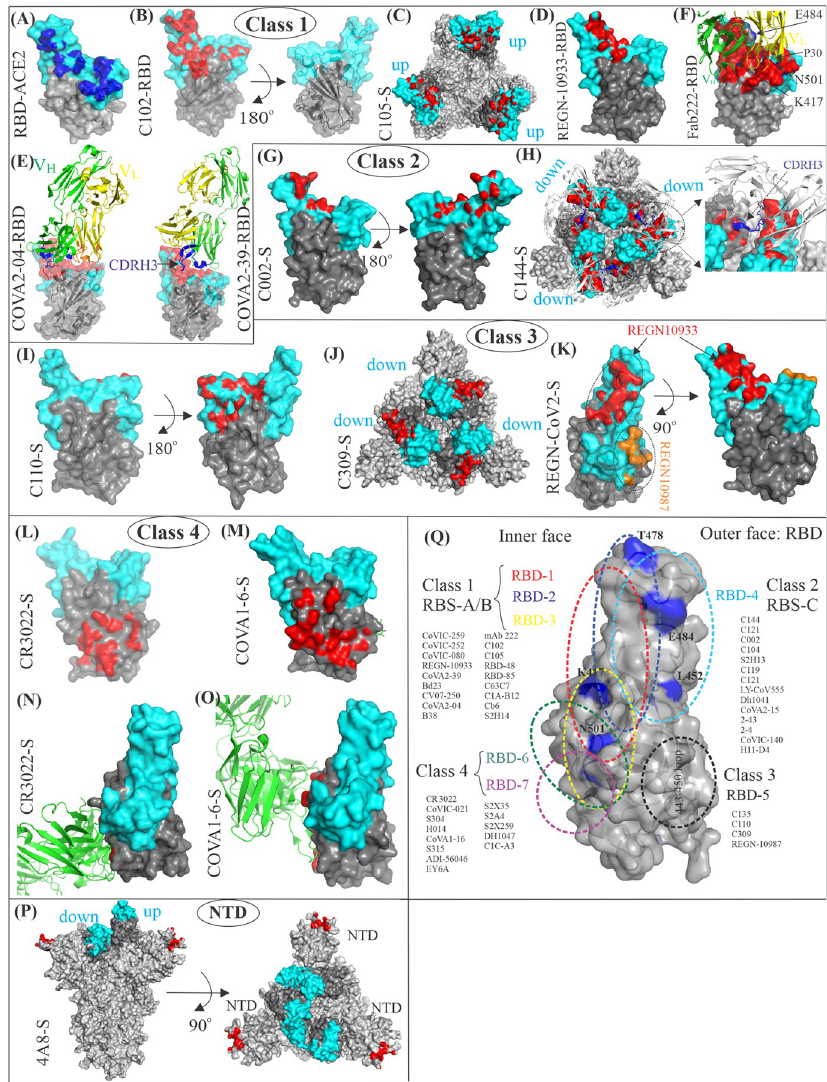
Fig 4. Structural analysis and classification of nAbs of the SARS-CoV-2 spike protein. (A) Structural footprints of ACE2 in blue on the RBM (cyan) (PDB: 6M0J). (B, C, D) The C102, C105, and REGN-10933 antibodies in complex with either isolated RBD or the spike trimer illustrate a conserved mode of binding to RBD in the up-conformation. Binding of C102 to the RBM on the RBD in red overlaps with the ACE2-binding site (PDB: 7K8M). (E) COVA2-39 (PDB: (7JMP) with a relatively longer CDRH3 loop binds the RBD in an alternative binding mode, as compared to the antibodies with a shorter CDRH3 loop, such as COVA2-04. (F) Fab222 binds RBD (PDB: 7NX6) with a relatively shorter CDRH3 loop. Residues K417, E484, and N501 are mutated in Alpha, Beta, and Gamma variants and are highlighted in red on the cyan ACE2-binding interface. (G) Structural footprints of a Class 2 antibody C002 on the RBD in red illustrates that the binding occurs toward the outer edge of the RBM (PDB: 7K8S). (H) The C144-spike protein complex structure revealed 3 C144 binding to a closed spike with all down-conformation RBDs (PDB: 7K90). The C144 epitope (red) spans between 2 adjacent RBDs on the surface of the trimeric spike. Close-up view of a quaternary epitope of C144 (red) bridging 2 adjacent monomers by the CDRH3 loop (blue). Class 1 and class 2 antibodies have significant overlap, but class 2 antibodies have fewer structural footprints on the ACE2-binding site at the RBM than class 1 antibodies (see B and G) (I) Structural footprints of a Class 3 antibody C110 on the RBD in red illustrates that C110 recognize a conserved epitope away from the receptor binding site and toward the outer face of the RBD. (J) The C309-spike protein structure illustrates that they bind outside of the ACE2-binding site. (PDB: 6WPS). (K) REGN-CoV2 is an antibody cocktail comprised of REGN10933 and REGN10987. REGN10933 blocks the ACE2-binding site like Class 1 antibodies, and REGN10987 sterically interferes with the ACE2 interactions like Class 3 antibodies. (L, M) Structural footprints of Class 4 antibodies CR3022 and COVA1-16 on the RBD in red, which illustrate that a conserved cryptic epitope accessible only in the up-conformation is recognized. The binding site